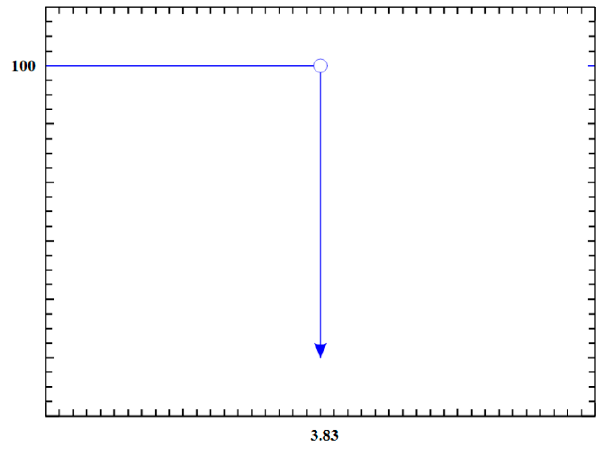
Figure 12. Inverted Dirac Delta function for BT02-MOD-Y.